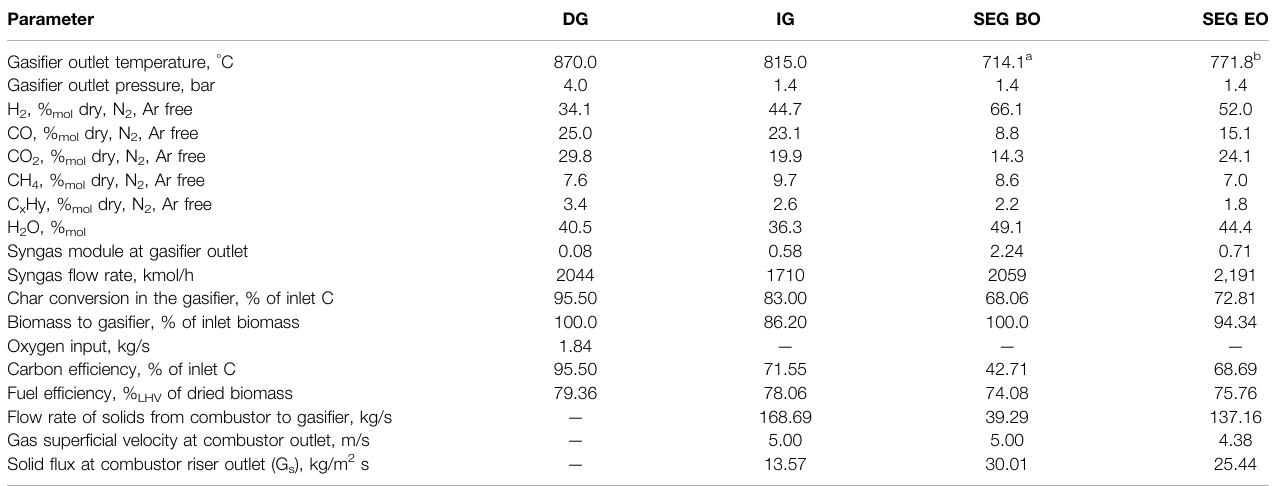
TABLE 1 | Gasi fi ers operating conditions and exit gas composition.